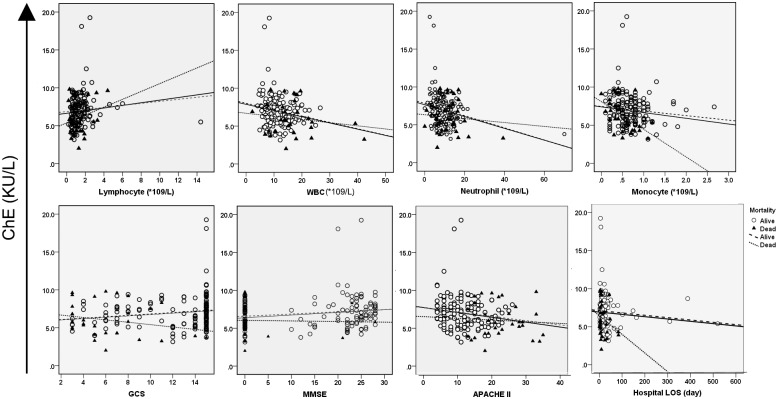
Scatterplot of the correlation of admission ChE activity with blood cell counts, neurocognitive scores, APACHE II score and hospital length of stay (LOS) in total population or in patients dichotomized by outcome.